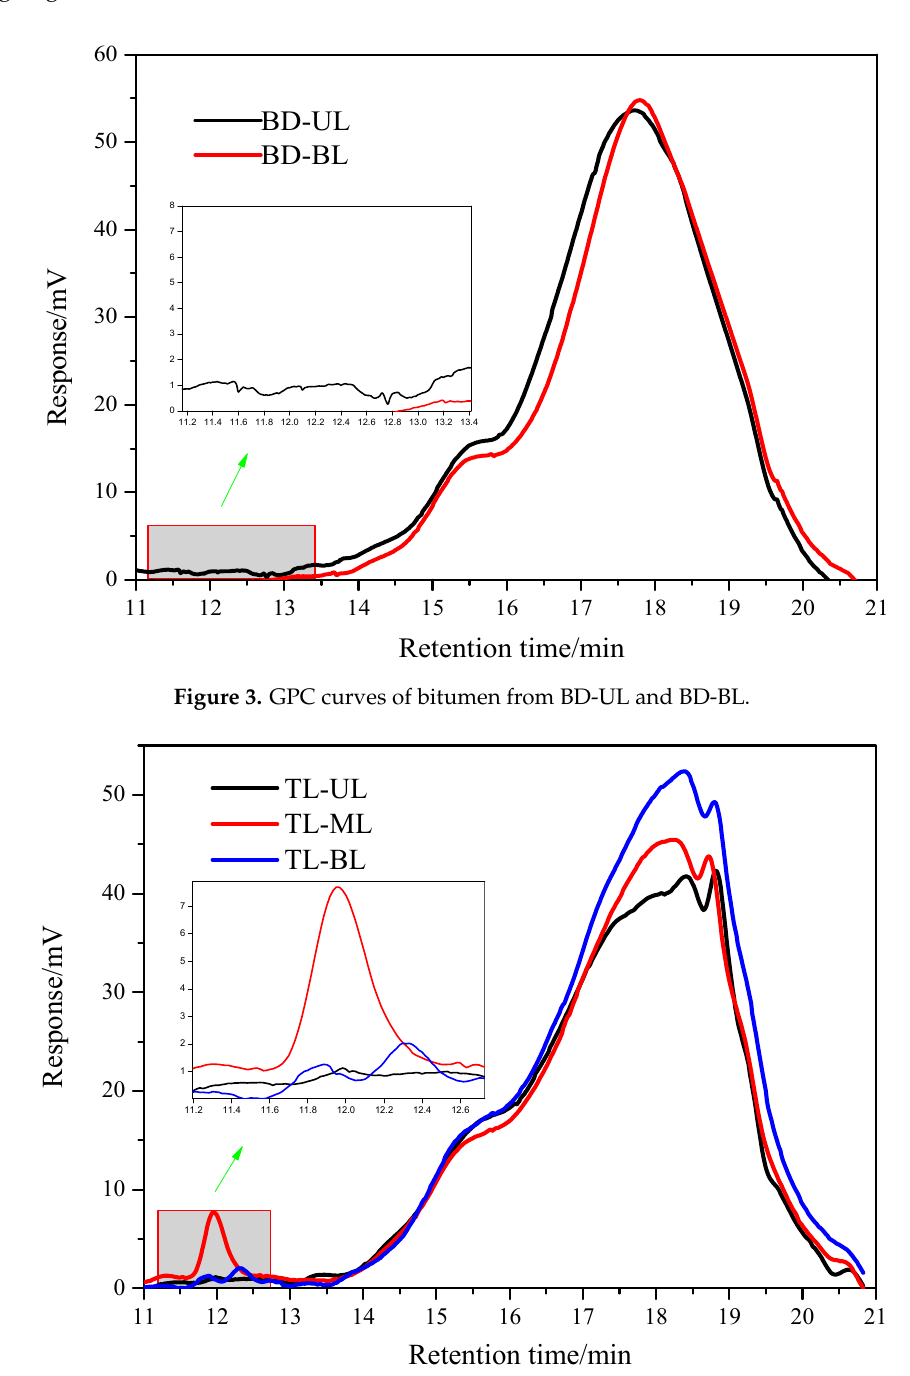
Figure 4. GPC curves of bitumen from TL-UL, TL-ML, and